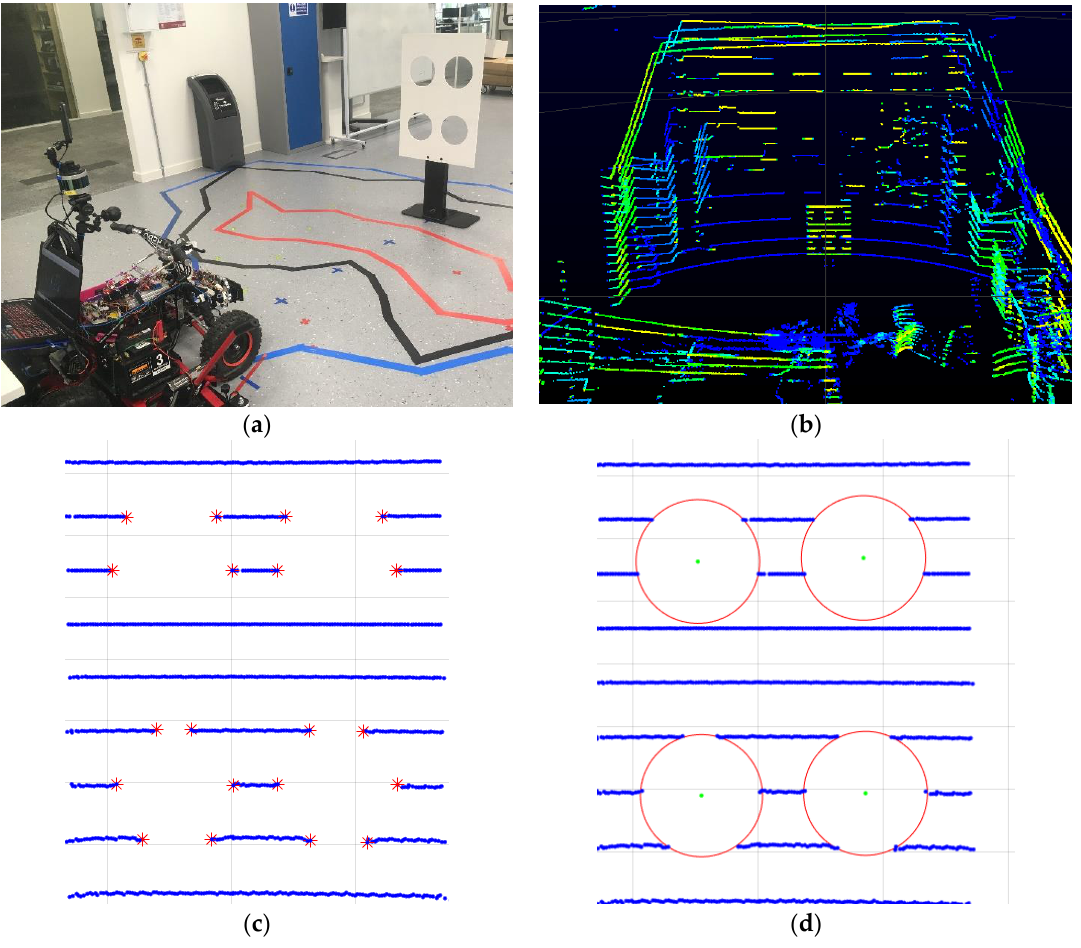
Figure 6. Steps in extrinsic calibration process. ( a ) Camera setup and calibration target; ( b ) The corresponding LiDAR capture; ( c ) Red points on the edges of the circle; ( d ) Identification of the circle centers.